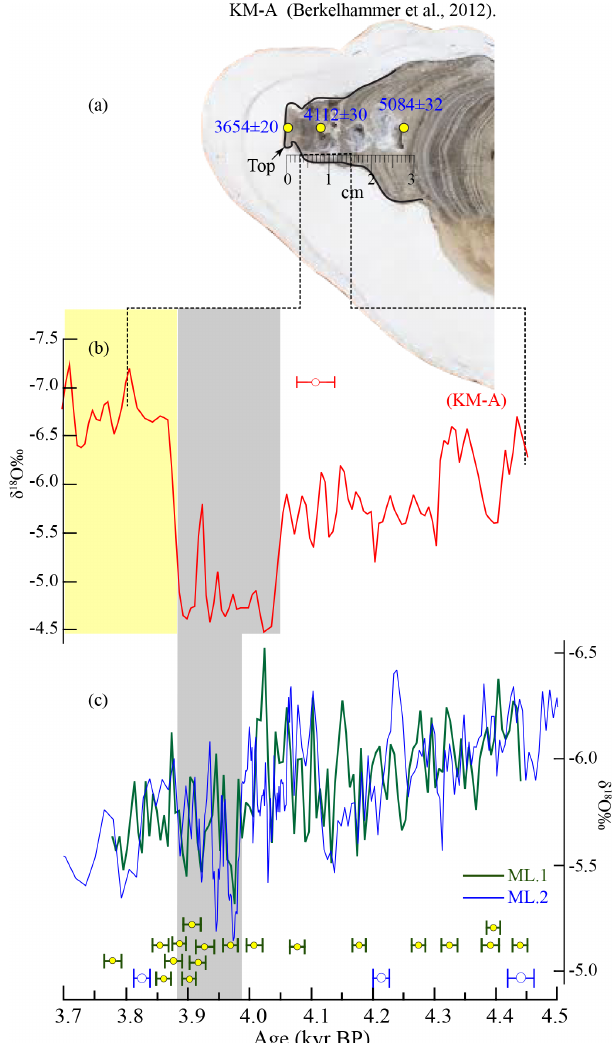
Figure 7. Comparison between the KM-A, ML.1, and ML2 δ 18 O profiles: (a) an image of KM-A stalagmite (Berkelhammer et al., 2012). The yellow dots indicate three 230 Th dates. The black curve marks the potential dissolution surface. The white aragonite layer above the dissolution surface was deposited after the 1950s with the advent of limestone mining above the Mawmluh Cave (Breitenbach et al., 2010). (b) The dotted lines delineate the portion of the KM-A δ 18 O record (red; ∼ 4 . 4ka to 3.654ka) (Berkelhammer et al., 2012) discussed in the text. (c) The ML.2 δ 18 O profile (blue) (this study) is overlaid by a 6-year interpolated ML.1 δ 18 O profile (green) (this study; see also Table S2). The horizontal error bars (red, green, and blue) on the 230 Th dates represent a 2 σ analytical error. The vertical gray bar indicates the inferred duration of weakest (driest phase) ISM as indicated by the KM-A and ML δ 18 O records. The yellow bar indicates the interval of anomalously depleted δ 18 O values in the KM-A